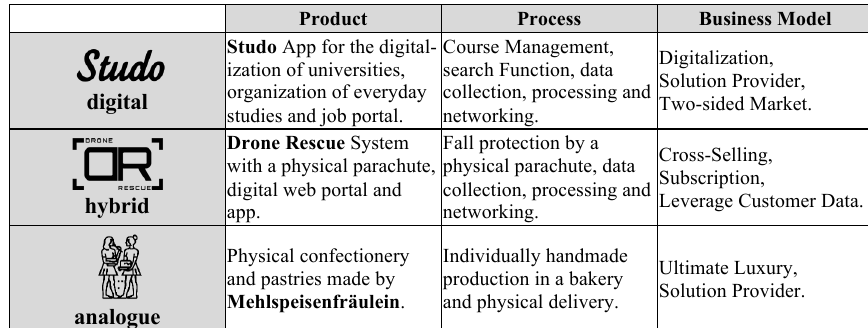
Table 2. Classification demonstrated in detail using three